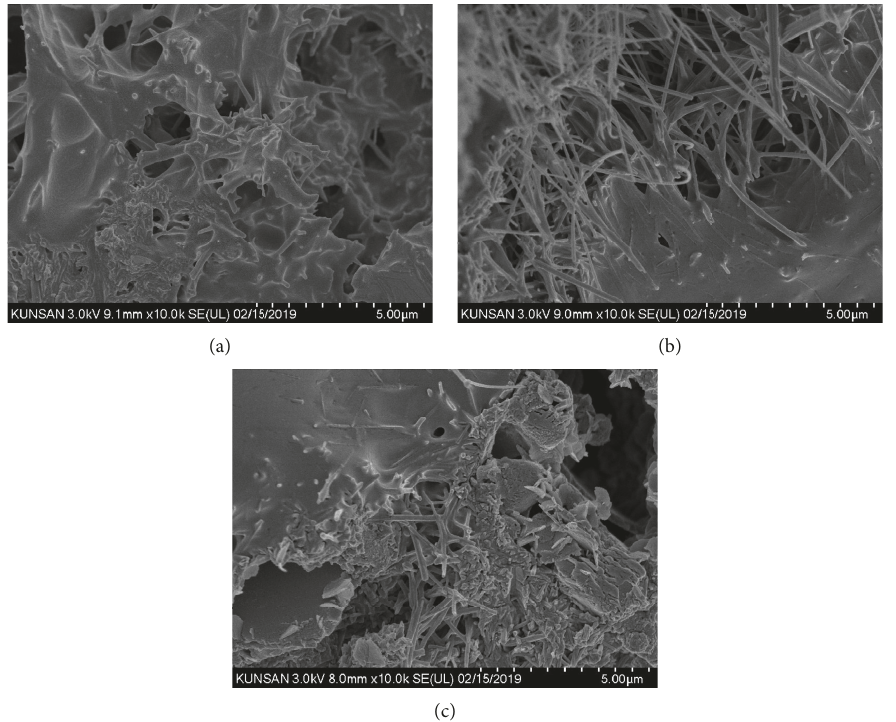
Figure 11: SEM test results of CAM mixtures: (a) mix FA30; (b) mix S30; (c) mix